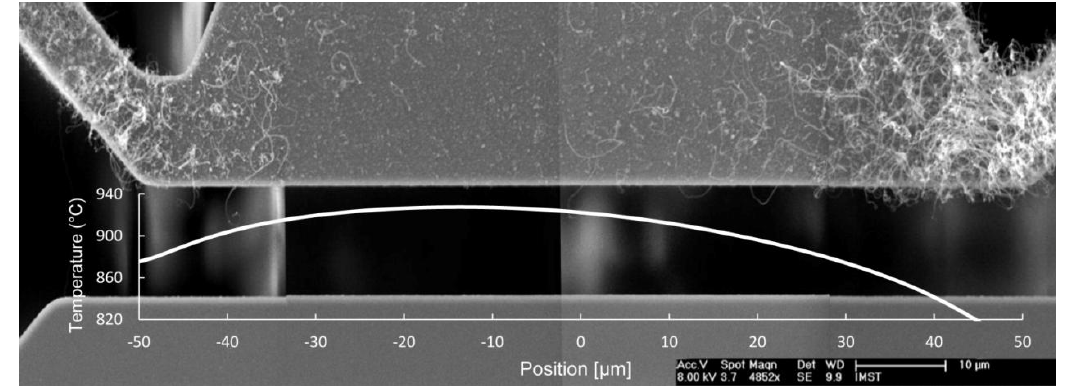
Figure 2. Scanning Electron Microscope (SEM) micrograph of microheater after CNT growth with simulated temperature profile, showing the asymmetrical temperature distribution, due to the Thomson